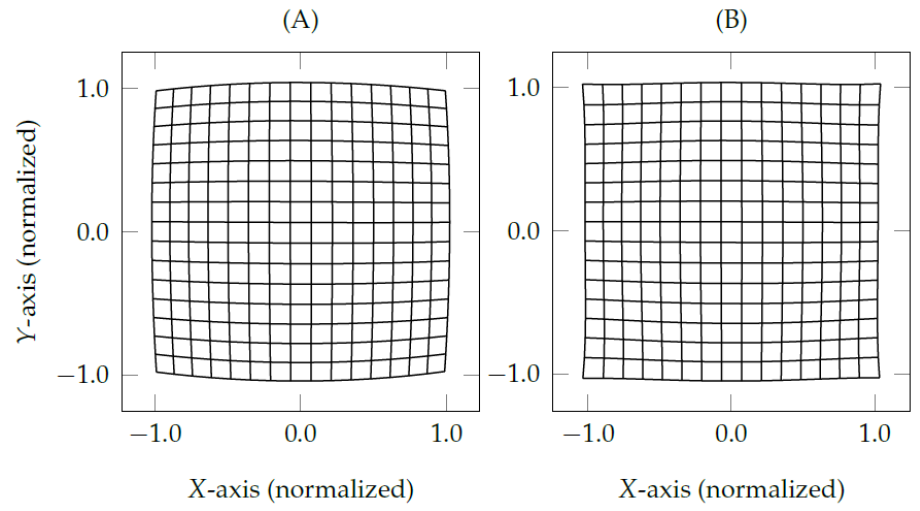
Figure 7. The eye feature distribution on the normalized space Π n presents a positive radial distortion (i.e., barrel distortion) available in most camera lenses. The grids represent a set of 16 × 16 simulated pupil centers from a remote eye tracker with the eye-camera placed at ( 0,350,0 ) . ( A ) shows the pupil center distribution over the influence of barrel effect, and ( B ) presents the result of the proposed eye feature distribution undistortion